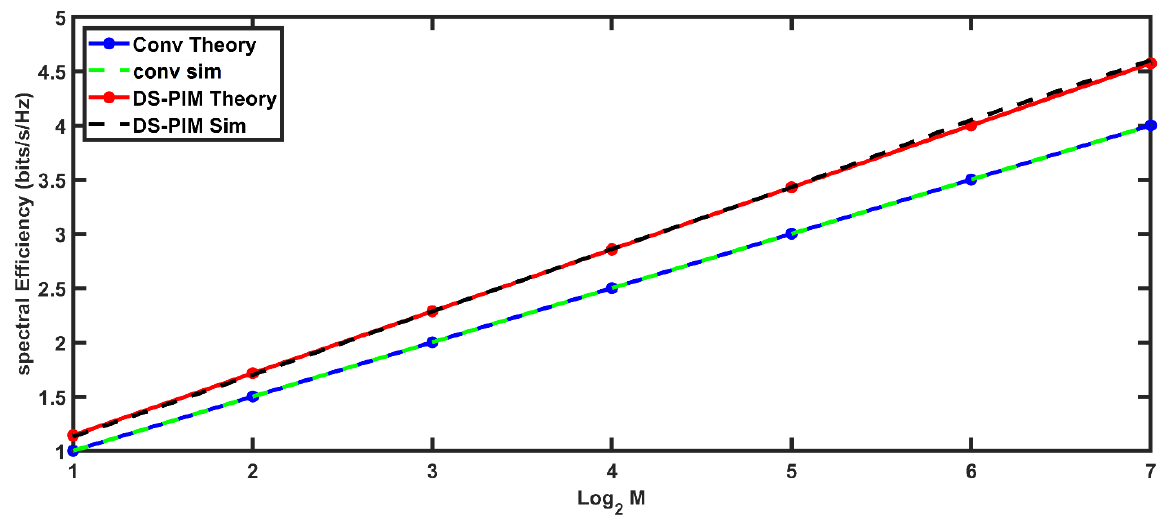
Figure 10. Theoretical vs. simulated results for spectral efficiency of conventional and DS-PIM-SIM OFDM.